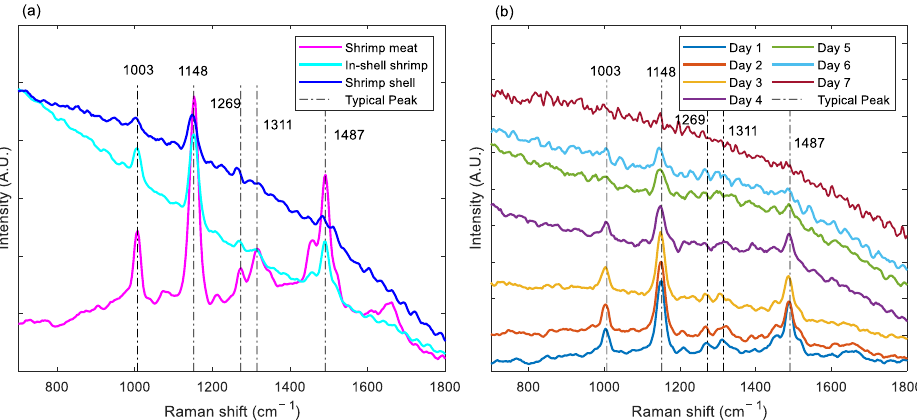
Figure 4. Raman spectra and typical peaks of ( a ) shrimp meat, in-shell shrimp, shrimp shells, and ( b ) spatially offset Raman spectra of in-shell shrimp within seven days of storage.